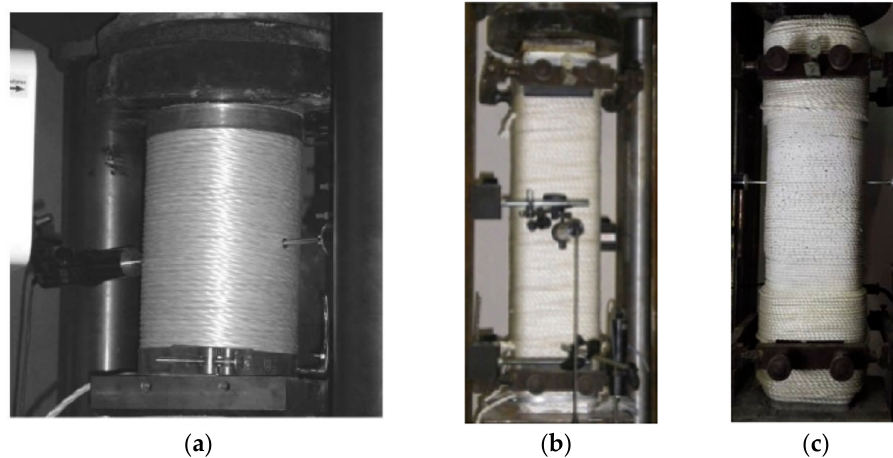
Figure 17. ( a ) Specimen VinL1v1R1 by [12] after the final cycle of loading; ( b ) specimen 500PPL4 by [13] before loading and ( c ) specimen RCPPL4 by [47] before loading.